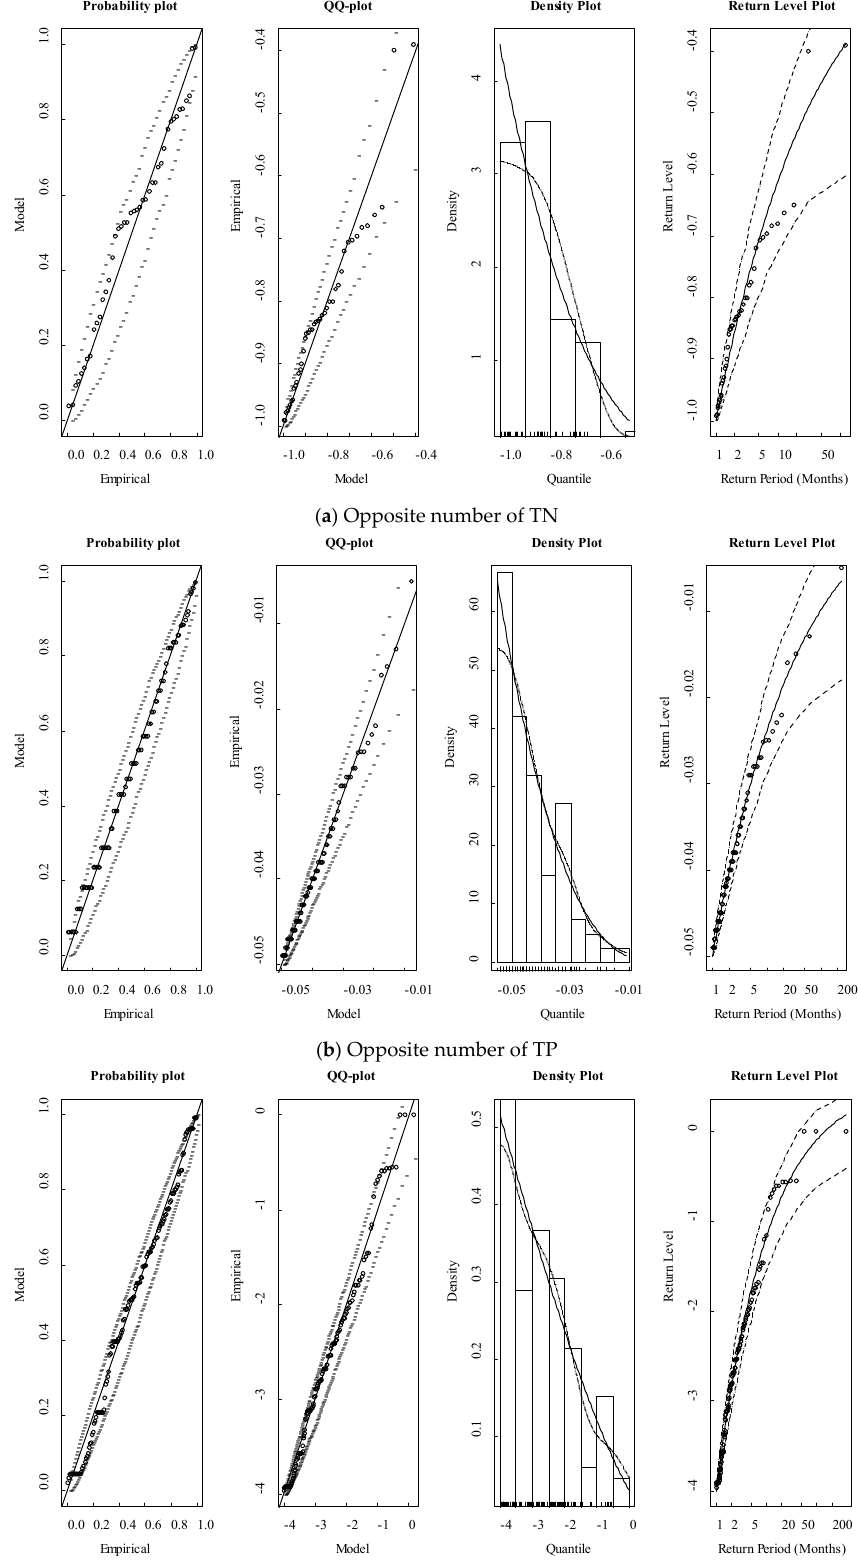
Figure 4. Diagnostic plots of the Markov–Extreme model on the opposite number of TN, TP, and chlorophyll a. The solid lines are the model results, dotted lines show the boundaries of the 95% confidence interval, and the points are the opposite number of observations higher than the